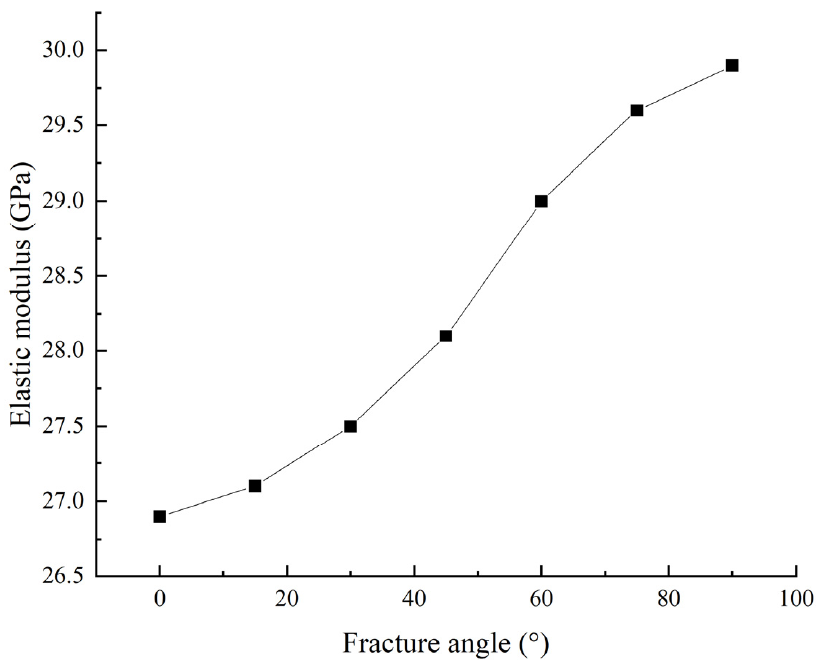
Figure 11. The elastic modulus increases with the fracture angle, which is smooth and linear. In order to eliminate data errors caused by too sharp cuboid boundaries, the fracture was set as ellipsoid. The current fracture angle was 60 ◦ . The stress distribution of this model is shown in Figure 12. The lower part of the fracture was the area with large stress, and the part above the plane where the fracture is located was the main source of